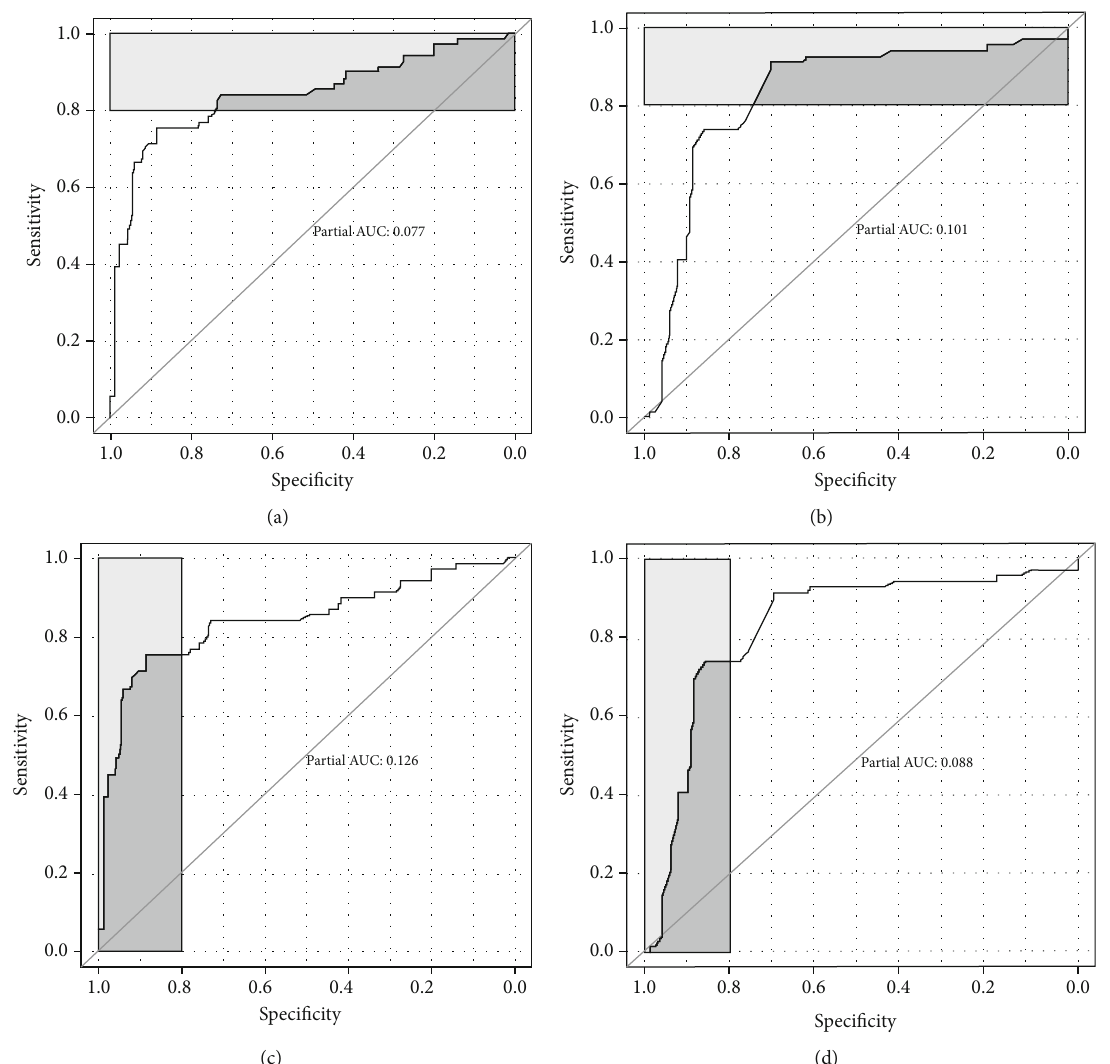
Figure 4: pAUC for fi brinogen and RDW was associated with ACS. Partial AUC (pAUC) is derived from focusing on a partial sensitivity or speci fi city: (a) pAUC of fi brinogen according to sensitivity > 80 %, pAUC = 0 : 077 ; (b) pAUC of RDW according to sensitivity > 80 %, pAUC = 0 : 101 ; (c) pAUC of fi brinogen according to specificity > 80 %, pAUC = 0 : 126 ; (d) pAUC of RDW according to specificity > 80 %, pAUC = 0 : 088